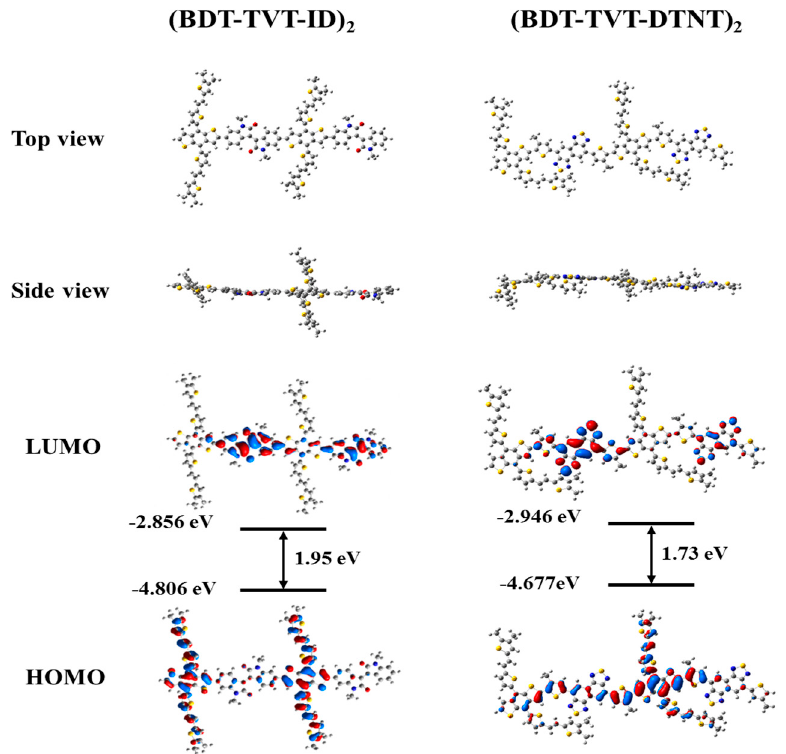
Figure 5. Optimized molecular geometries and molecular orbital of the Highest Occupied Molecular Orbital (HOMO) and Lowest Unoccupied Molecular Orbital (LUMO) for polymers.